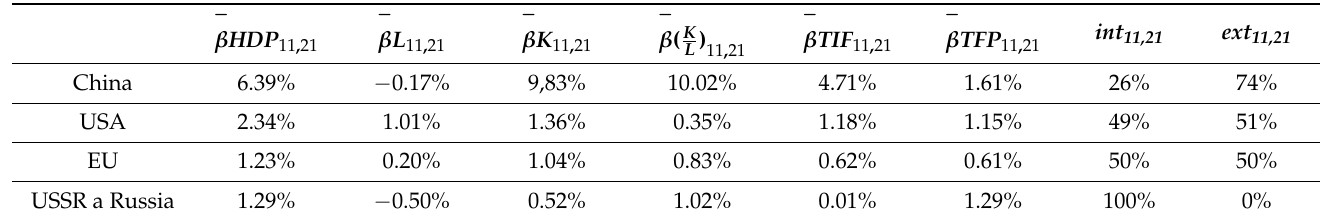
Figure 7. Averrage values of dynamic intensity and extensity indicators for the period 2011 – 2021. Despite the fact that the analysis is based on a relatively small amount of input data, it provides a rich indication of the quality of the development in several dimensions. The change in the output of the analyzed countries is characterized by the average annual relative change in the GDP at constant prices. China reported the highest average year- on-year relative change over 60 years (the period of 1961 – 2021) and in the past 10 years (the period of 2011 – 2021), followed by the US. The EU15 ranked third over 60 years, but was overtaken by Russia in the period of 2011 – 2021. The differences in the intensities are very small over the last 60 years, in the range of 6 percentage points. This is a consequence of technical progress being a worldwide phenomenon. Sooner or later, innovation will be realized globally. Significant differences in intensity are evident for the period of 2011 – 2021. In Europe and the US, the influence of intensive factors continues to grow, approach- ing 50%. China, on the other hand, showed a decrease in intensity against the 60-year average. China experienced major innovation in previous decades, especially after 1976, when China became one of the leaders in technology and innovation, something that slowed down in the period of 2011 – 2021. The intensive growth seen in Russia during the